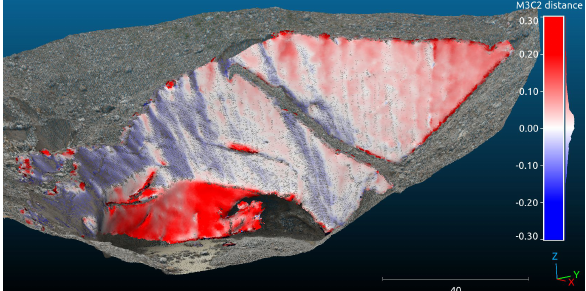
Figure 11. Cloud-to-cloud distances, computed with M3C2 algorithm, between the UAV-based ground truth point cloud (displayed with RGB colors) and the stereo-point cloud (displayed with a color scale). The colors represent the average distance (i.e., error) between each point of the stereo-point cloud (seed point) and the points of the UAV cloud that falls within a cylinder oriented as the local normal computed around the seed point. Most of the points have an error smaller than ± 10cm , with the highest values concentrated within the